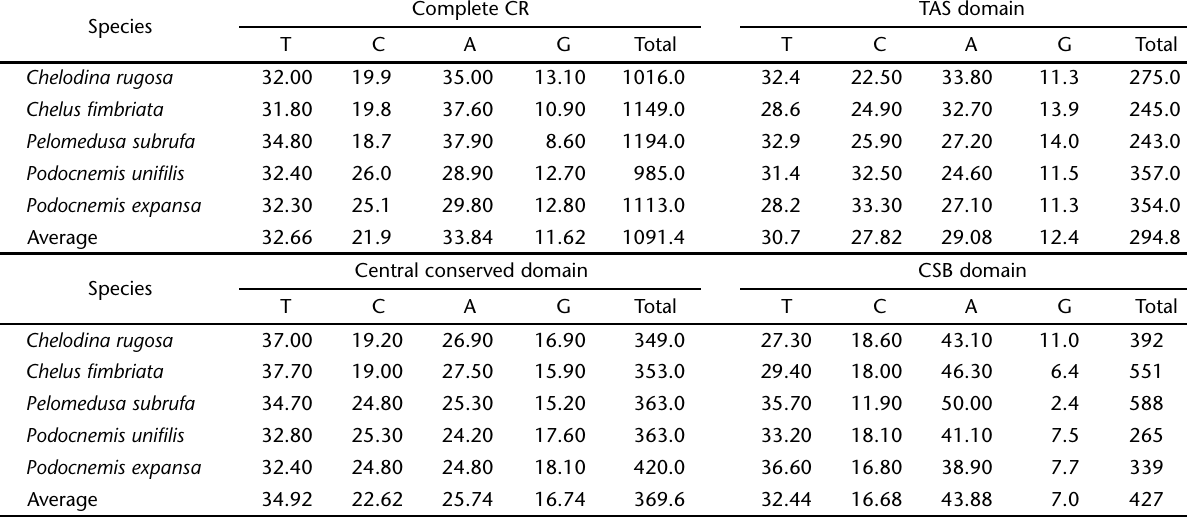
Table I. The base composition (%) and length of the five pleurodiran turtle CRs.